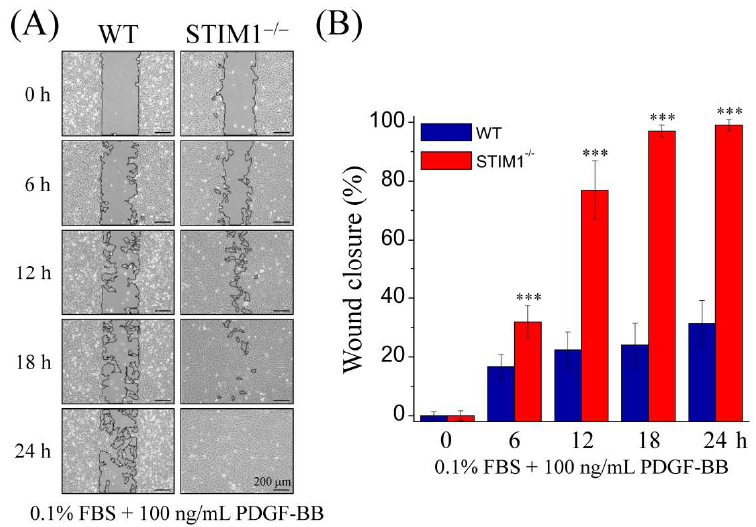
Figure 8. PDGF-BB induces cell migration in MEF-STIM1 −/− cells. ( A ) MEF-WT and MEF-STIM1 −/− cells were seeded into silicon inserts with 0.5% fecal bovine serum (FBS) medium. Following cell adhesion, inserts were removed, followed by the addition of Dulbecco’s modified Eagle’s medium (DMEM) with 0.1% FBS + PDGF-BB (100 ng/mL) for 24 h. Phase images were captured using inverted phase-contrast microscopy and wound spaces were analyzed using ImageJ; ( B ) Comparison of the effects of PDGF-BB-induced wound closure following insert removal in MEF-WT and MEF-STIM1 −/− cells. Cellular migratory ability is presented as the percentages of wound closure. Bars represent mean ± SEM. ***: p < 0.001 by Student’s t -test. Scale bars = 200 μm.